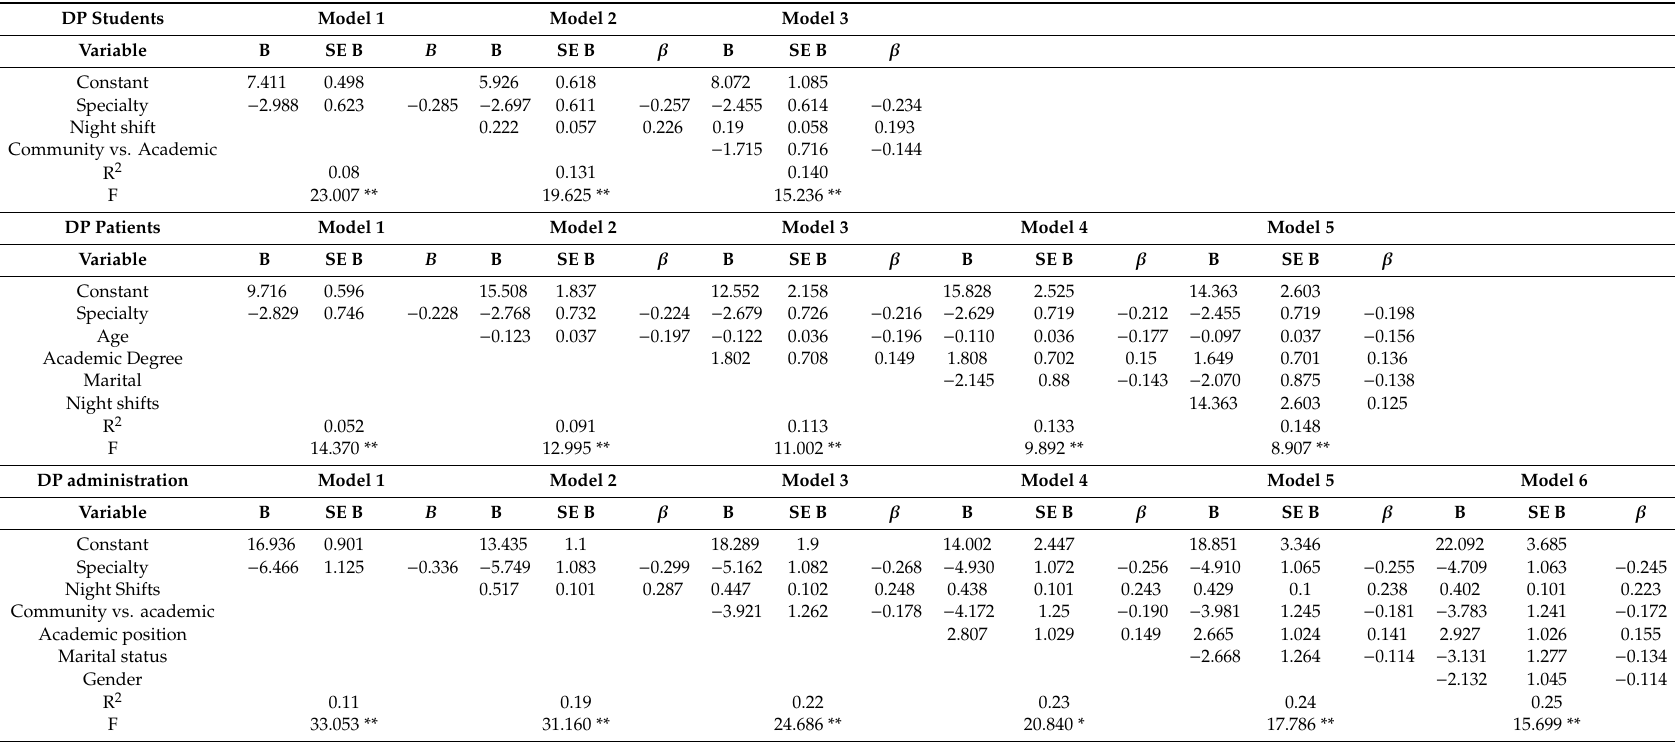
Table A5. Linear Regression for depersonalization (DP)